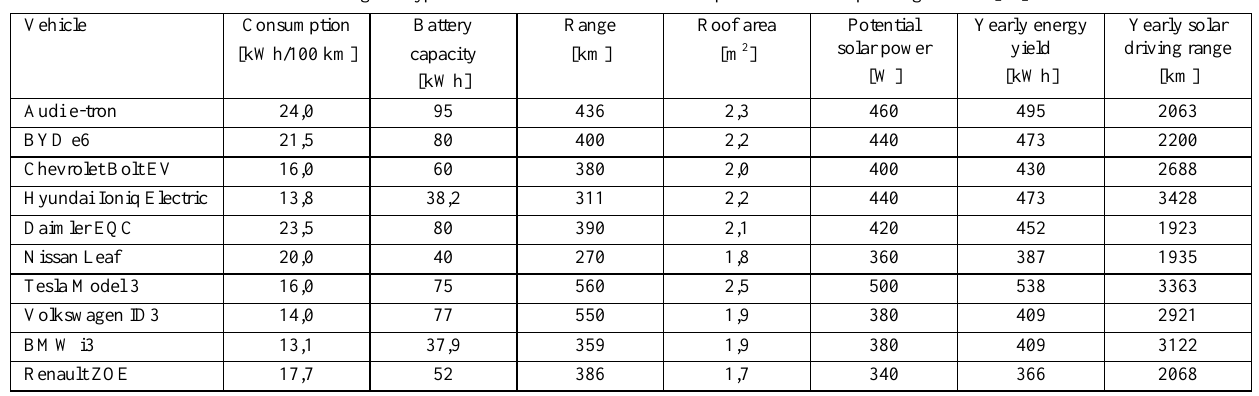
Table 1. Investigated types of electric vehicles and selected parameters corresponding to them [44]